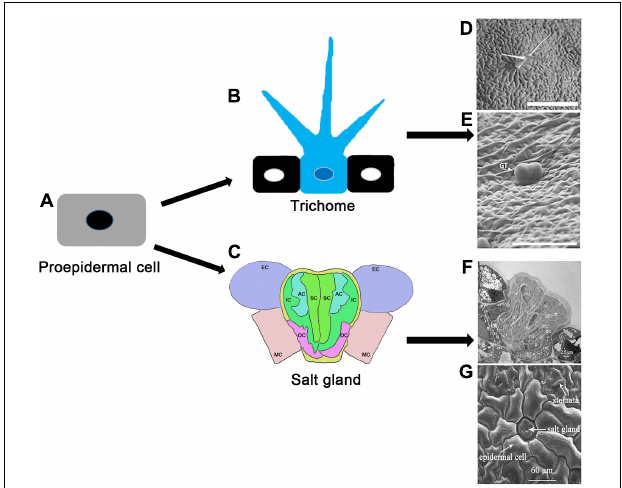
FIGURE 5 | Possible evolutionary patterns in trichome and salt gland development (Breuer et al., 2009; Yuan et al., 2015b, 2016a; Chalvin et